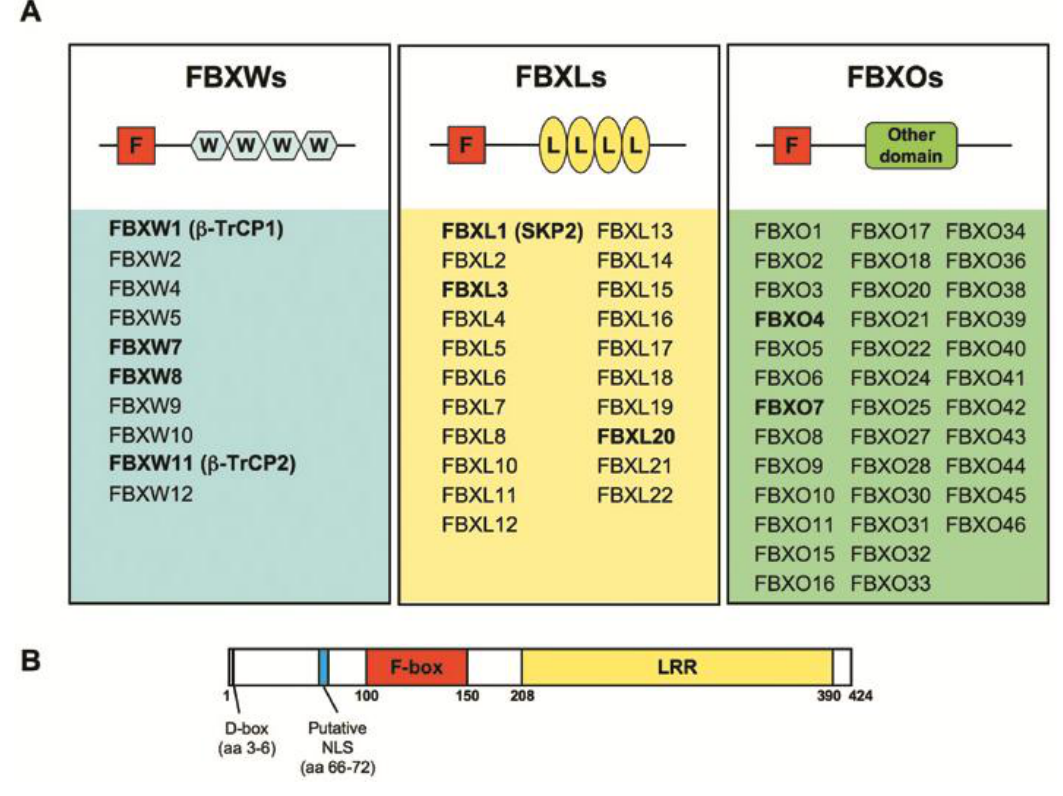
FIGURE 1. The family of human F-box proteins and domain structure of human Skp2 protein. (A) Based on the types of substrate-interaction domains, human F-box proteins are classified into three categories: FBXWs are those with WD40 repeats, FBXLs are those with LRR, and FBXOs are those with other diverse protein-interaction domains or no recognizable domains. Simplified conceptual schematic representations of these three classes are shown, including F-box motif (F), WD40 repeat (W), LRR (L), and other types of domains (other domain), and 68 human F-box proteins are classified and listed below, which have well-characterized or proposed substrates indicated in bold. (B) Functional domains of human Skp2 protein are indicated, including the destruction box (D-box), which is required for the APC/Cdh1-mediated degradation of Skp2 (amino acids 3–6), F- box motif, and LRR. A putative nuclear localization sequence (NLS) is also indicated (amino acids